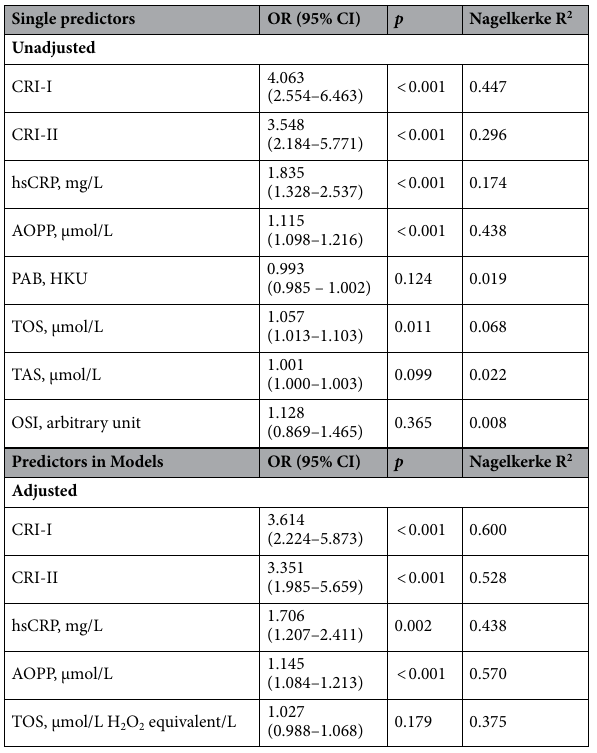
Table 3. Estimated odds ratios after binary logistic regression analysis for NAFLD groups as dependent variable. Data are given as OR (95% CI). Models included each marker and categorical variables (glycemic status, antihypertensive therapy and gender). CRI-I-Castelli’s Risk Index I; CRI-II-Castelli’s Risk Index II; hsCRP-High sensitivity C–reactive protein; AOPP-Advanced oxidation protein products; PAB-Prooxidant- antioxidant balance; TOS-Total oxidant status; TAS-Total antioxidant status; OSI-Oxidative-stress